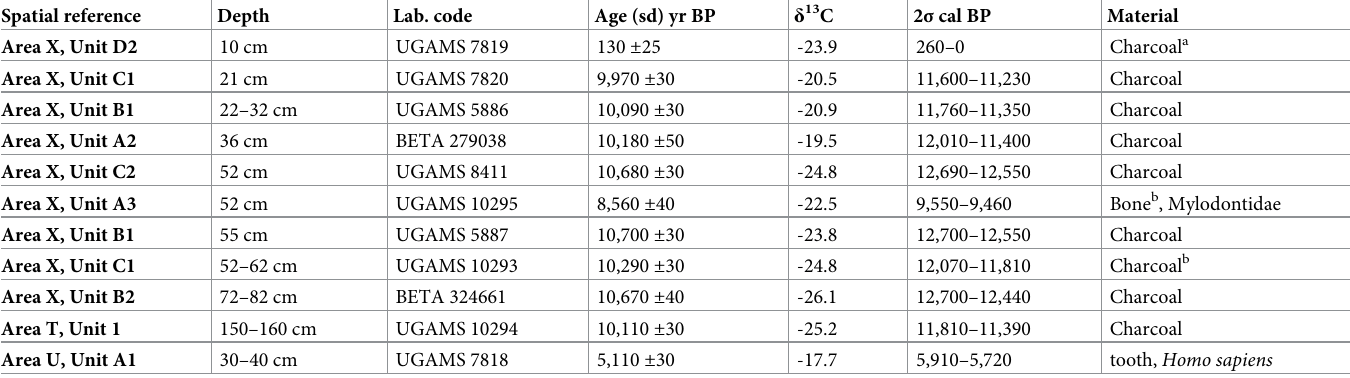
Table 1. Radiocarbon chronology of the Valiente